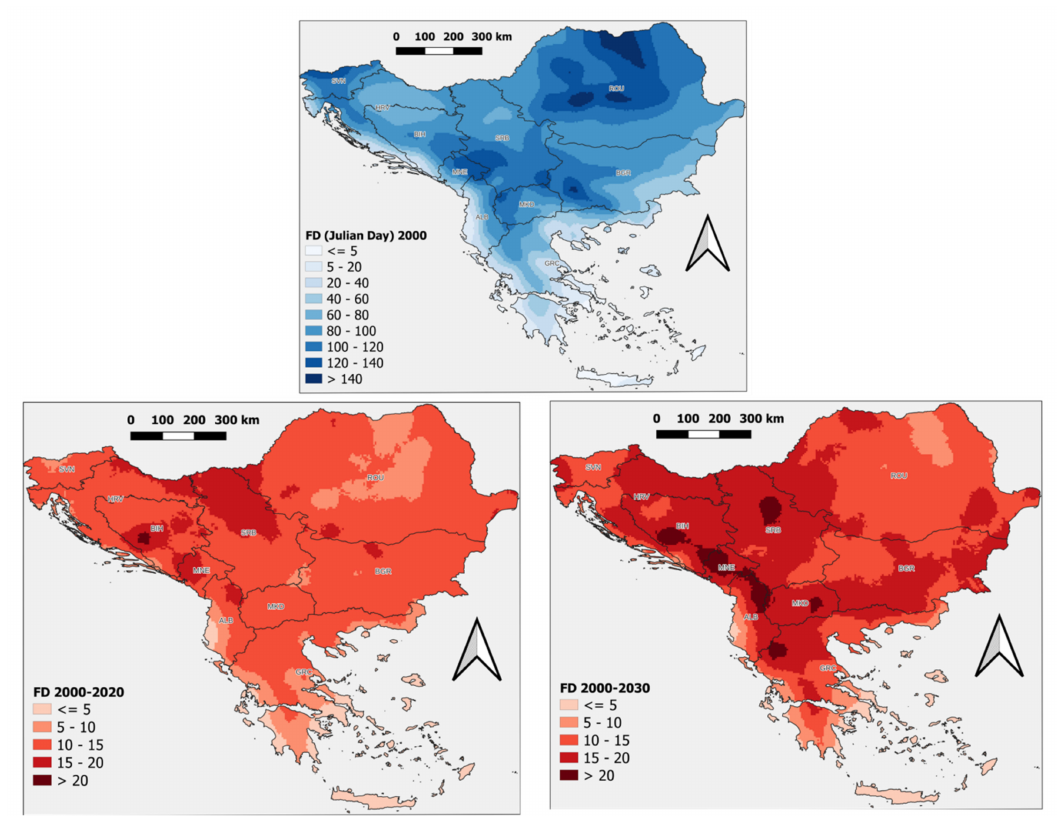
Figure 4. The number of Frost Days (FD) during the reference period ( upper image), the difference between the reference period and the 2020 horizon ( down right ) and the difference between the reference period and the 2030 horizon ( down left ).